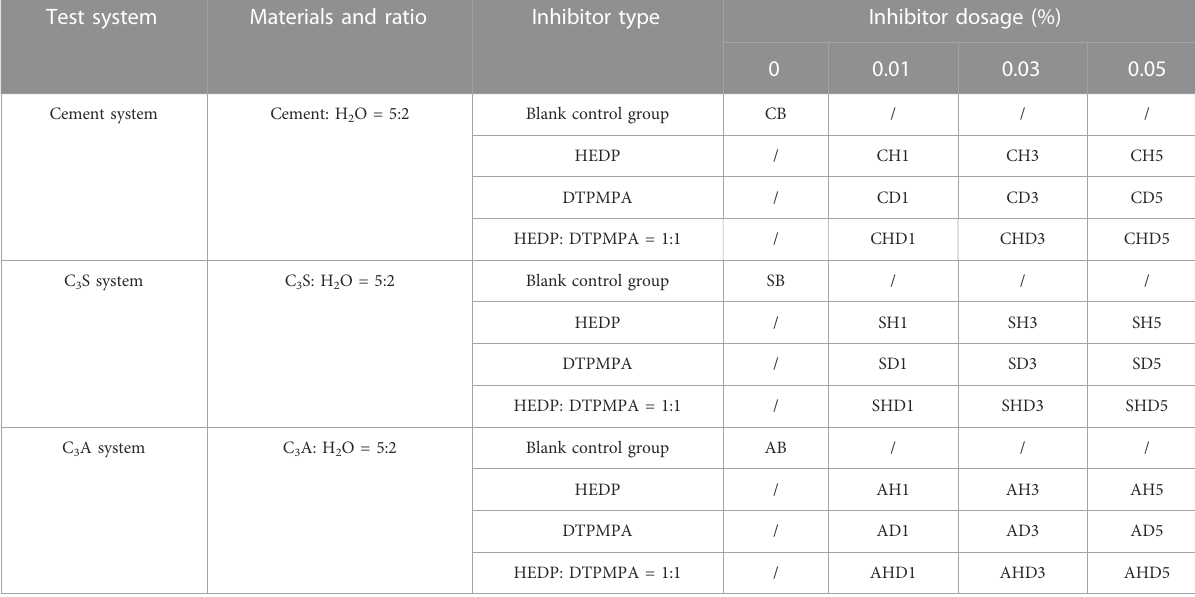
TABLE 4 Test parameters during microcalorimetric analyses of